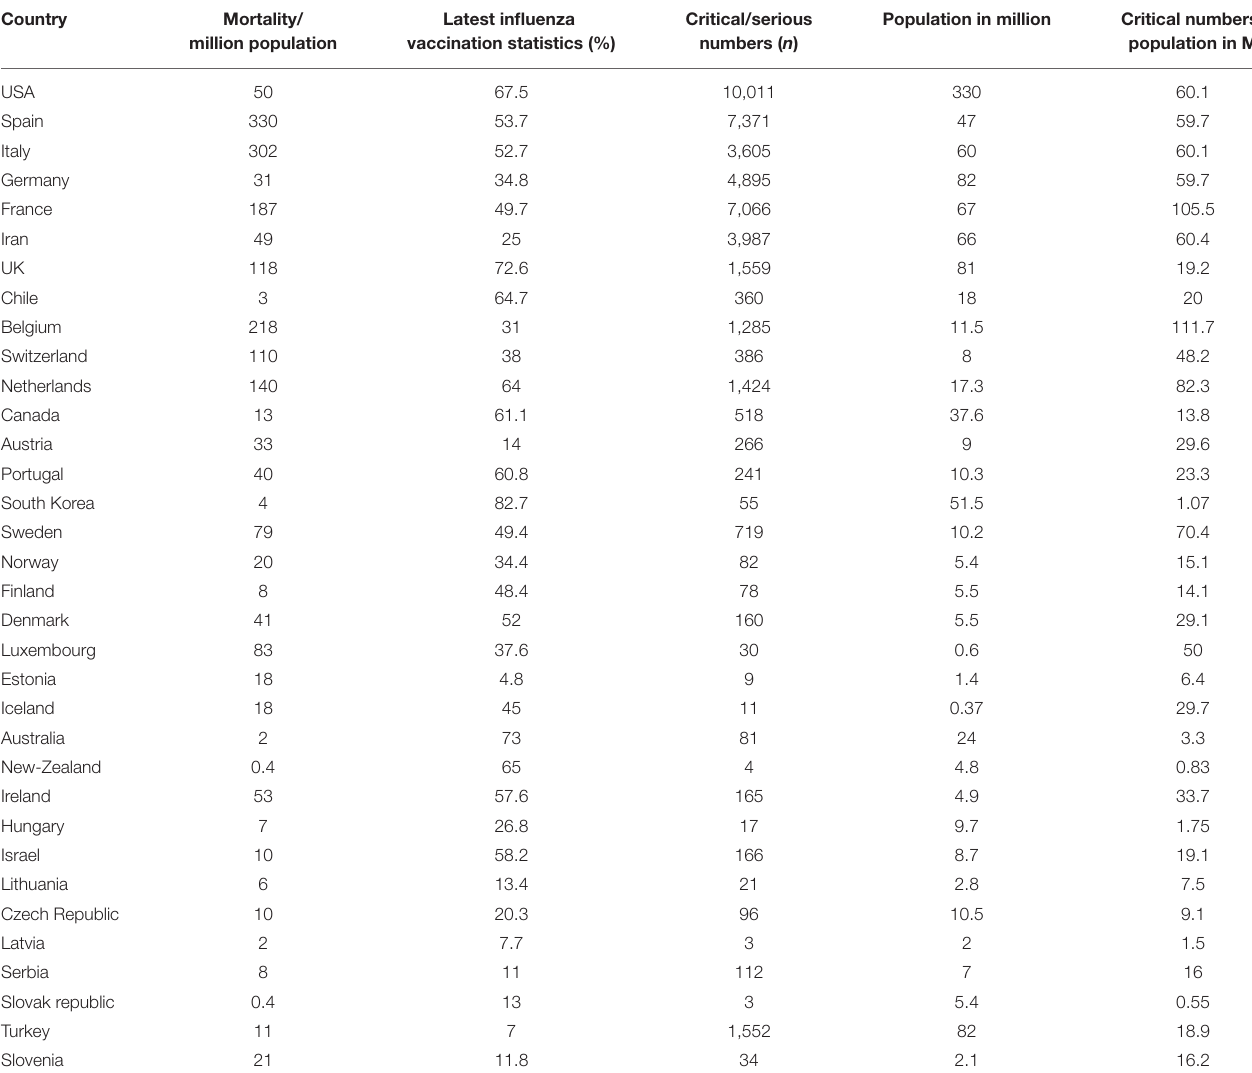
TABLE 1 | Incidence of mortality and critical position of the patient and influenza vaccination status (age ≥ 65 years) in different countries (April 10, 2020). Country Mortality/ Latest